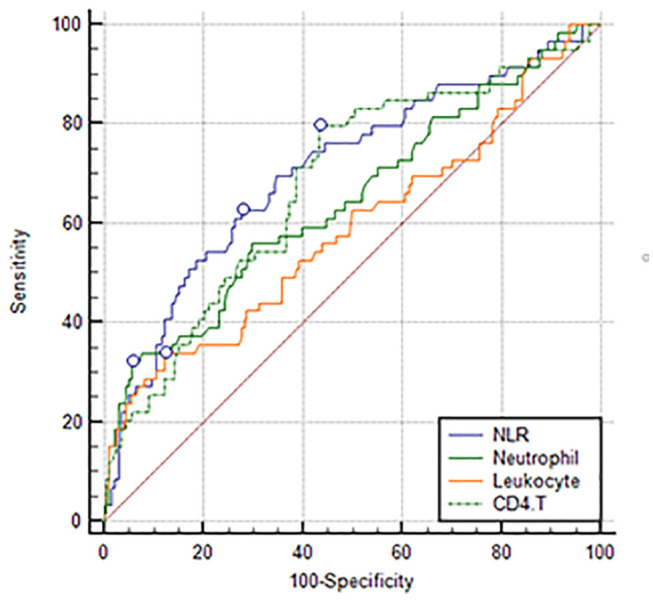
Predictive power comparison between NLR and other inflammatory markers.